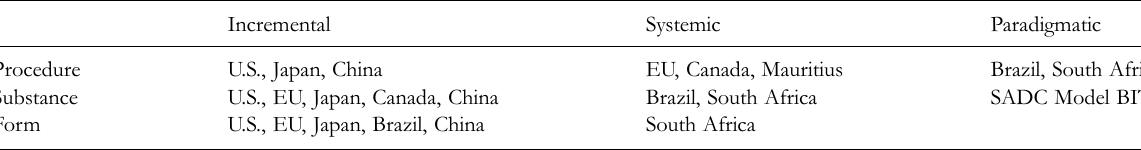
Table 1. States and Organizations on the Reform